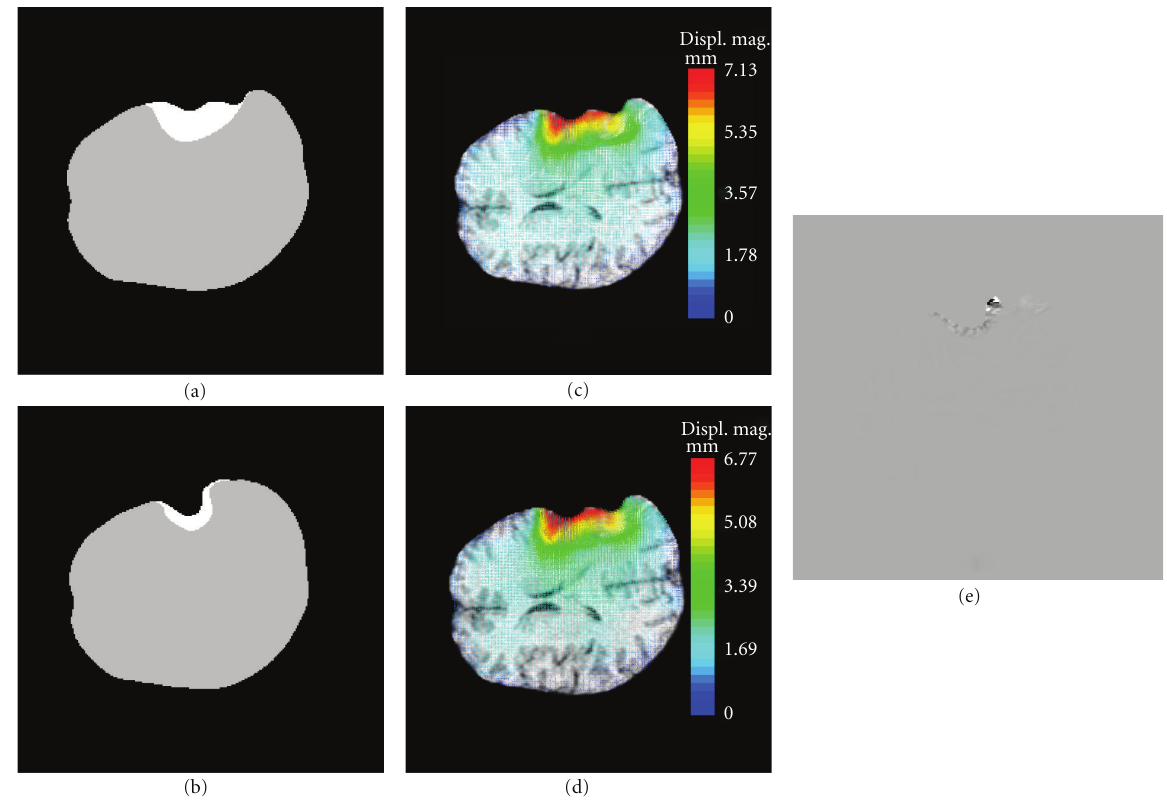
Figure 7: Di ff erence of results using XFEM and FEM for 3rd resection modeling (second patient case). (a) Healthy-brain (gray) and tumor (white) regions segmented out from the 4th iMR image. (b) Healthy-brain and tumor regions segmented out from the 5th iMR image. (c) Volume displacement field of biomechanical model using XFEM. The part of tissue falling within the resection cavity is modeled as being removed. Color levels correspond to the magnitude of the displacement field. (d) Same as (c), but for FEM. The part of tissue falling within the resection cavity is present in the deformation modeling even though it no longer exists. Di ff erence of magnitude between volume displacement fields using XFEM (c) and FEM (d) does not exceed 0 . 36mm. (e) Di ff erence in the warping of the part of the 4th iMR image corresponding to the whole-brain region using XFEM and FEM.